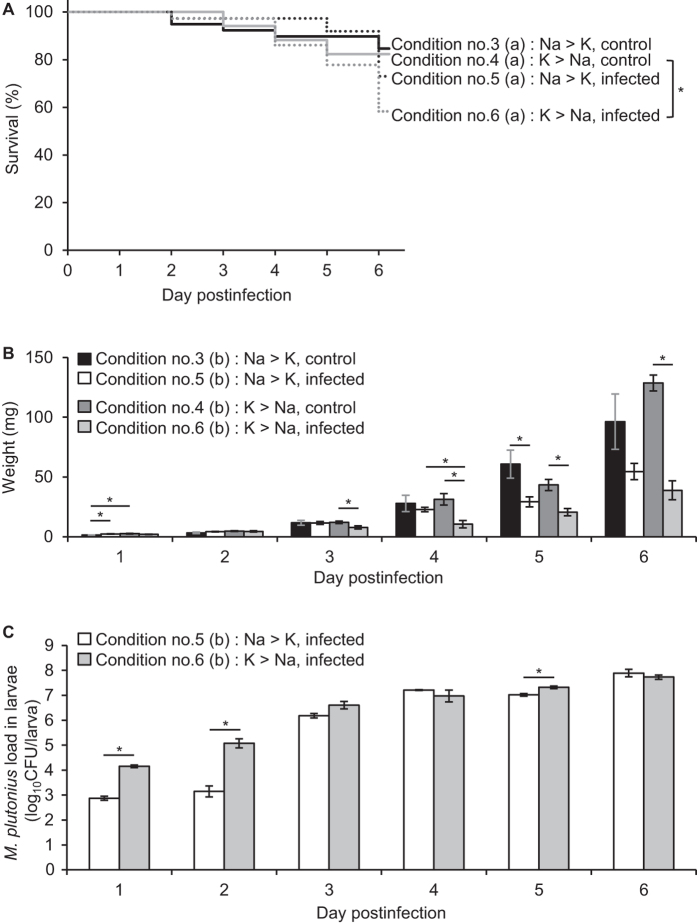
The influence of Na:K ratio in the Day 0 diet on symptoms of infected larvae (experimental condition nos 3–6).(A) Survival of control and infected larvae. Larvae in infected groups (nos 5 and 6) were fed with 10-μl Day 0 diet containing M. plutonius DAT606(CC3) at a final concentration of 1.7–2.1 × 107 CFU/ml (Supplementary Table S1). Survival rates at day 6 pi were 84.6% (no. 3), 82.4% (no. 4), 73.0% (no. 5), and 58.3% (no. 6). Asterisk indicates a significant difference in the survival rate at day 6 pi (Fisher’s exact test, P < 0.05). (B) Larval weight presented as mg (mean ± SEM). Larvae in infected groups (nos 5 and 6) were fed with 10-μl Day 0 diet containing M. plutonius DAT606(CC3) at a final concentration of 1.3–1.4 × 107 CFU/ml (Supplementary Table S1). Five larvae were randomly selected from each group daily and weighed. The larvae were also used for determination of bacterial loads in the larvae. Statistical differences were analysed between two control groups (nos 3 and 4), two infected groups (nos 5 and 6) and control and infected groups (between nos 3 and 5 and between nos 4 and 6). Asterisks indicate a significant difference (two-tailed Student t-test, P < 0.05). (C) Bacterial loads in infected larvae calculated by real-time PCR and presented as log10CFU/larva (mean ± SEM). Asterisks indicate a significant difference (two-tailed Student t-test, P < 0.05). Total no. of larvae used for each experiment is shown in Supplementary Table S1.